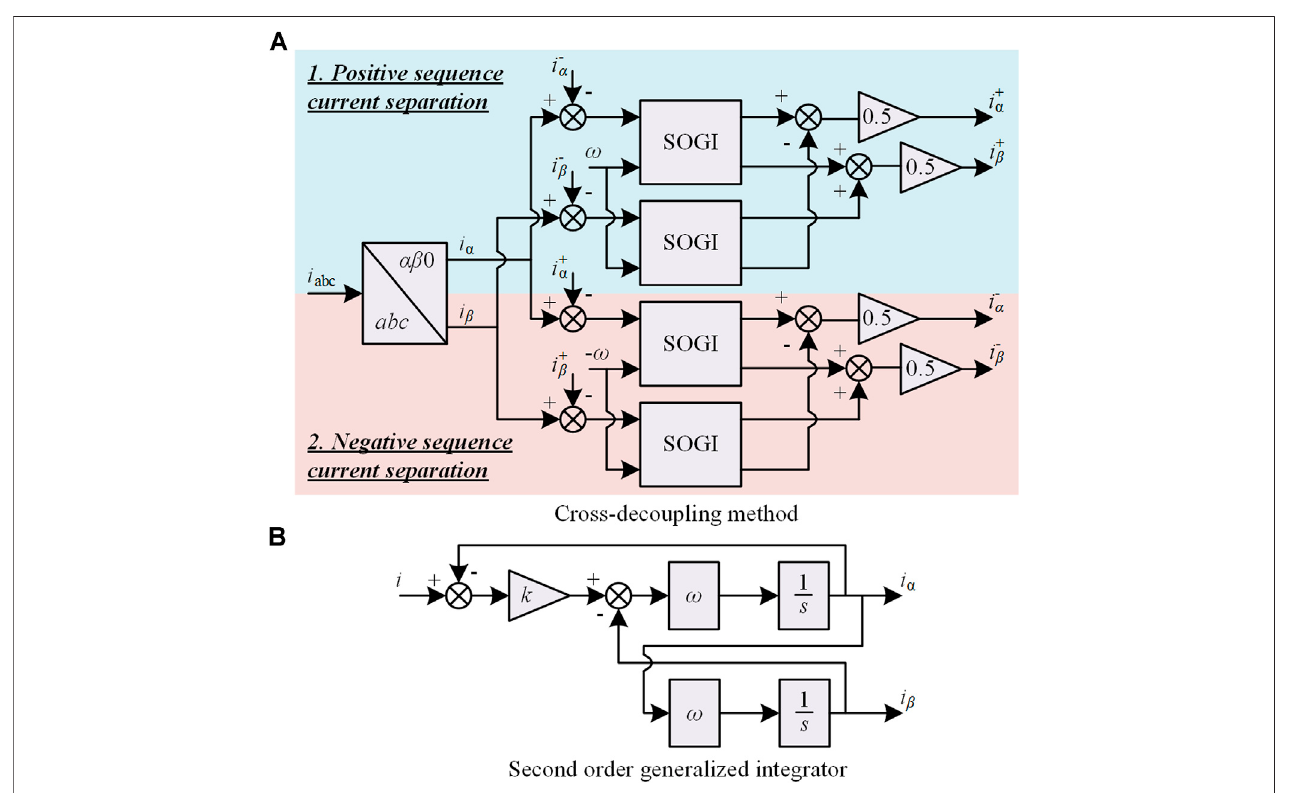
FIGURE 5 | Positive and negative sequence separation method with